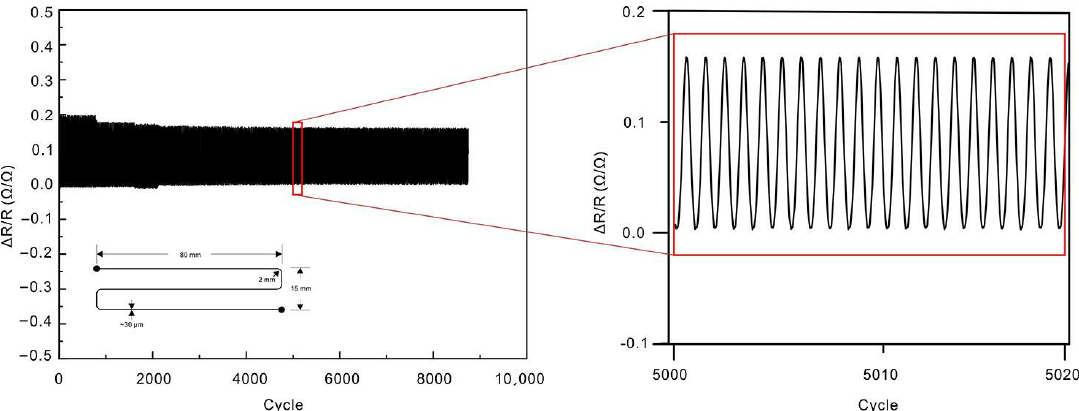
Figure 10. Results of resistance for encapsulated strain sensor in tensile tests. The strain sensor can be stretched more than 25% for nearly 9000 cycles. As the strain at X and Y direction was a bit different during the test, the liquid alloy reflowed within the PDMS channel due to its high fluidity, and a tiny width and height change was happened along the channel. Therefore, the resistance variation during the first 2000 cycles is a little higher before dynamic balance of liquid metal distributions